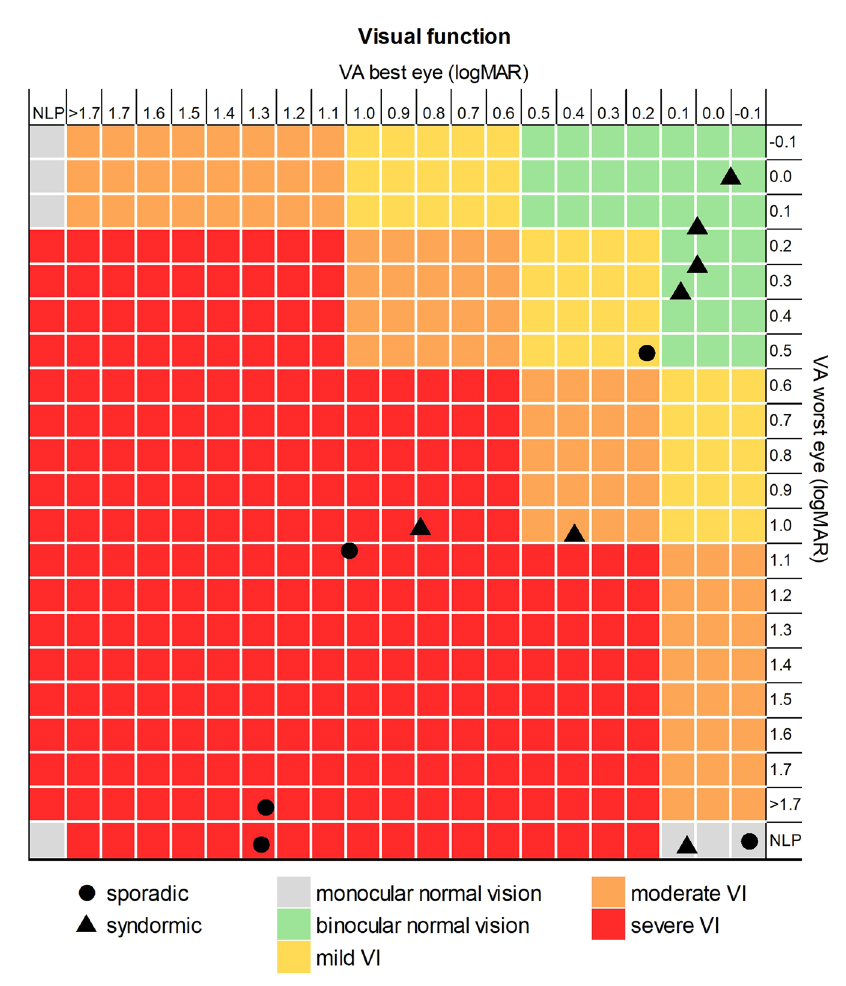
Figure 1. Classification of the visual acuity scores of the best (x-axis) and worst (y-axis) eyes of each study participant, either with sporadic (circles) or syndromic (triangles) OPG. Children were grouped into five categories: binocular normal vision (green), monocular normal vision (grey), mild visual impairment (yellow), moderate visual impairment (orange) and severe visual impairment (red). VA = visual acuity; VI = visual impairment; NLP = no light